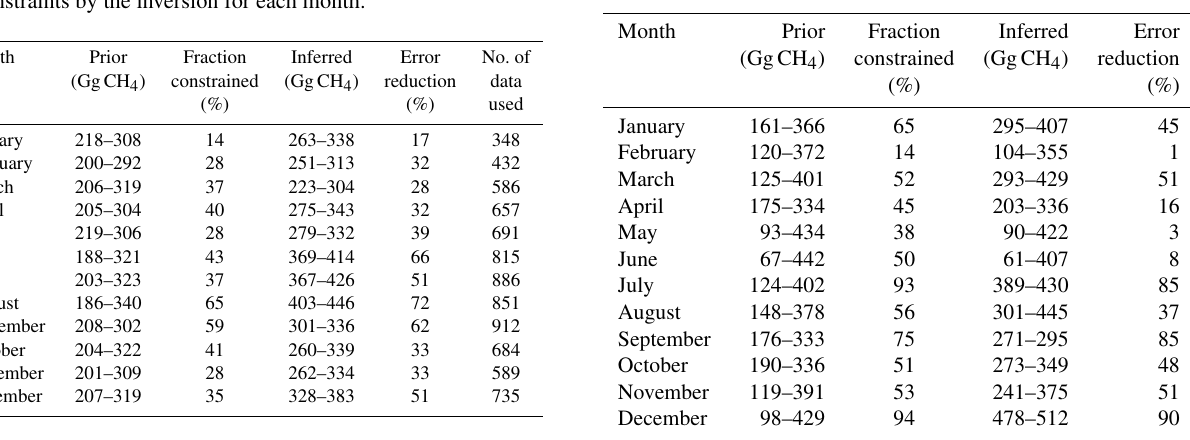
Table 4. Sectorial run: French monthly total CH 4 emissions (in GgCH 4 ) in 2012: prior confidence range (provided by our method, see Sect. 2.3), fraction of prior constrained by the inversion in %, confidence range for the inferred emissions and error reduction in % (see Sect. 2.3 for